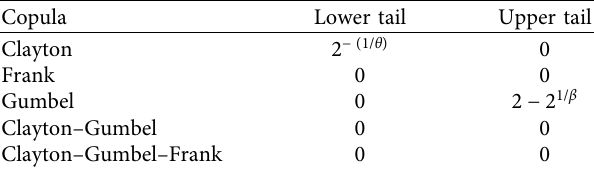
Table 1: The dependence coefficient